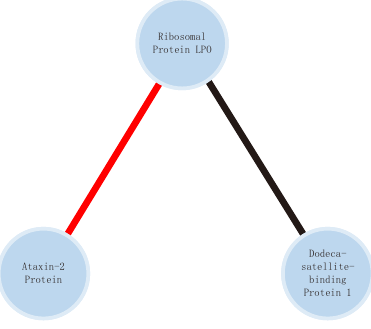
Figure 1. An example of positive and negative interactions between protein nodes. The red edge indicates positive interaction and the black edge indicates negative interaction.